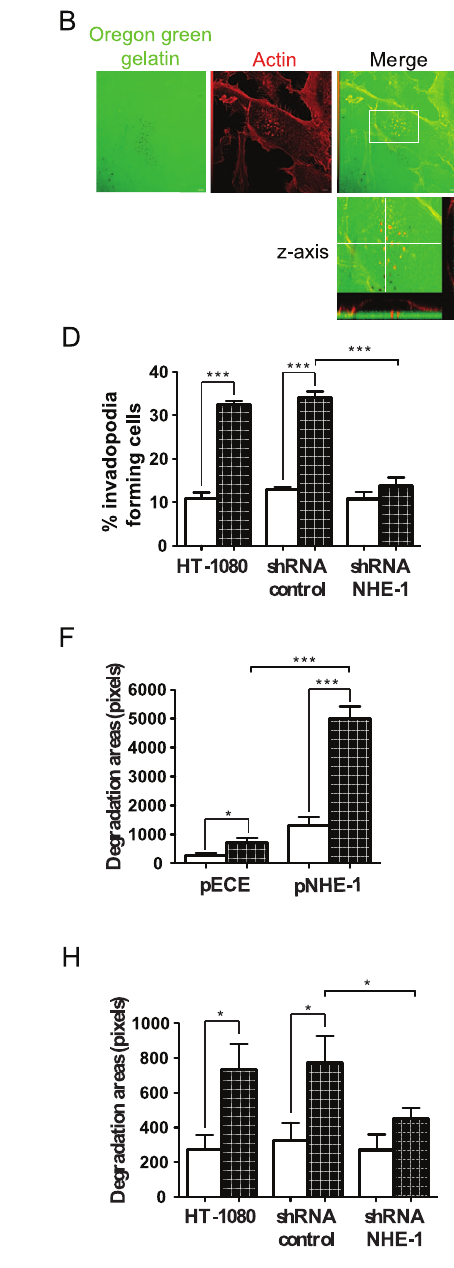
Figure 3. Hypoxia-induced NHE-1 activity promotes invadopodia formation. HT-1080 cells exposed to normoxic (empty bars) or hypoxic (filled bars) conditions were cultured on a layer of Oregon Green-labeled gelatin for 10 h and stained with Texas Red-phalloidin (actin) and DAPI (nucleus). The percentage of cells that formed invadopodia was determined by fluorescence microscopy. (A) Percentage of invadopodia-forming cells cultured in medium at pH 7.4 or 6.6 (n=3). (B) Representative confocal microscopy image showing actin staining at sites of Oregon Green-gelatin degradation. Boxed area is enlarged in the corresponding lower panel. The merged image also shows a reconstruction of the x-z profile (inset) through the plane indicated by the solid line within the image. (C–D) Percentage of invadopodia-forming HT-1080 cells (C) transfected with pNHE-1 or an empty vector (pECE) (n=3) or, (D) transfected with control (scrambled) or NHE-1 shRNA (n=3–4). Number of invadopodia formed per cell (actin/cortactin clusters), and corresponding area of degradation per cell, quantified from 20 random fields per experiment, in cells (E–F) transfected with pNHE-1 or an empty control vector (pECE) (n=2–3) or, (G–H) transfected with NHE-1 shRNA or control (scrambled) shRNA (n=2–3). Columns represent the mean 6 SEM indicated by the horizontal bars. The asterisks correspond to, * p , 0.01; ** p , 0.001; *** p , 0.0001. NHE-1 activation, HT-1080 cells were incubated in the presence in cells treated with BI-D1870 or in cells expressing the dominant or the absence of the selective p90RSK inhibitor BI-D1870 or, negative form of p90RSK, respectively (Figure 5B–5C). The need were transfected with a dominant negative form of p90RSK [41] for NHE-1 Ser 703 phosphorylation in hypoxia-induced NHE-1 activation was investigated in HT-1080 cells transfected with a prior to exposure to hypoxic conditions. Results showed that non-phophorylatable mutant form (S703A) of NHE-1. Results hypoxia-induced NHE-1 activity was inhibited by 60% and 40%